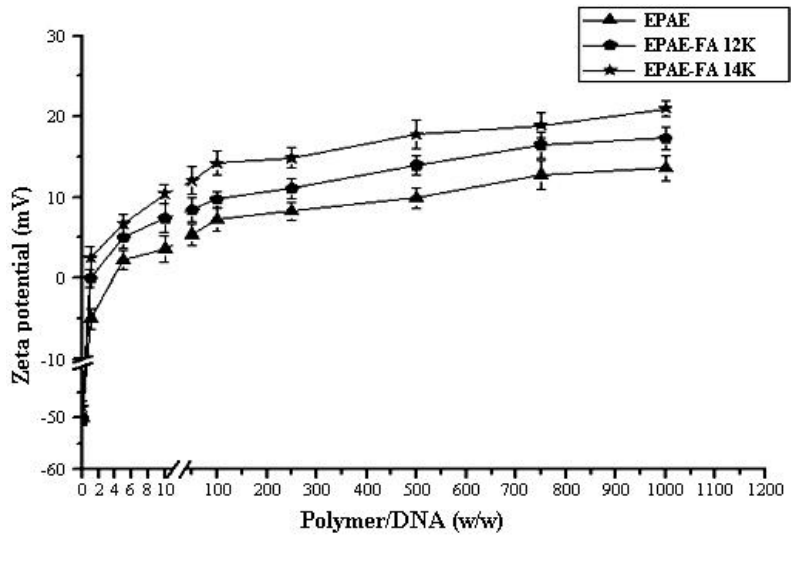
Figure 3. Zeta-potential of EPAE/DNA and EPAE-FAs/DNA complexes prepared at various mass ratios. Results are presented as the mean ± SD (n = 3).